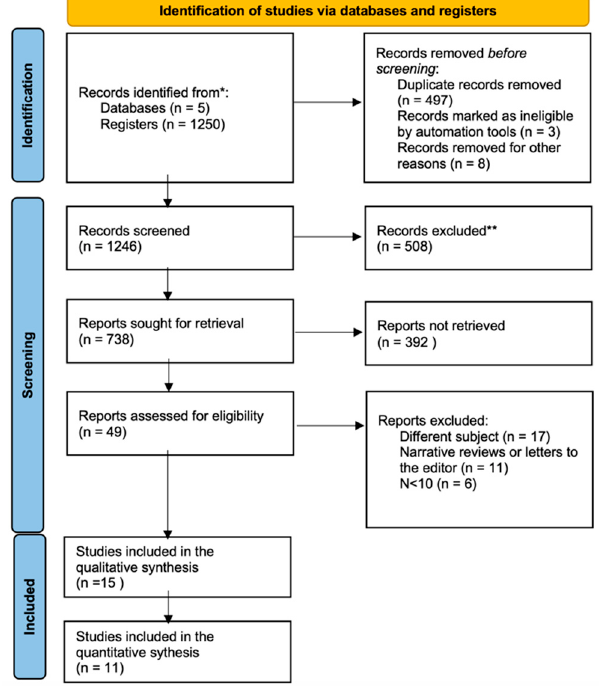
Figure 1. PRISMA 2020 flow diagram for new systematic reviews which included searches of databases and registers only [24]. (* Consider, if feasible to do so, reporting the number of records identified from each database or register searched (rather than the total number across all databases/registers). ** If automation tools were used, indicate how many records were excluded by a human and how many were excluded by automation tools).